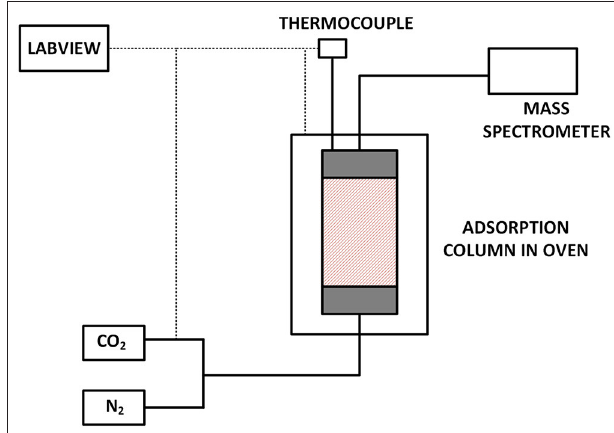
FIGURE 3 | Schematic of the breakthrough setup used in this work.